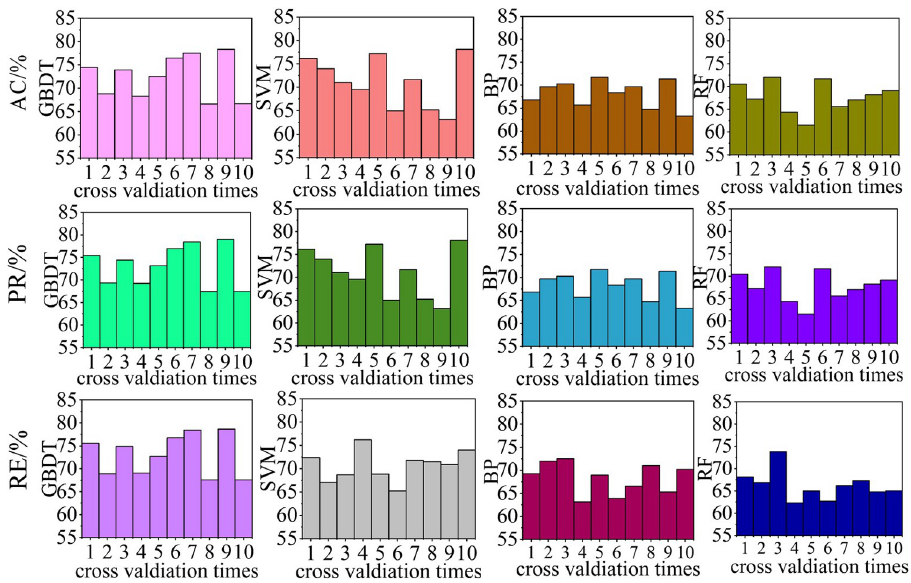
Fig 24. Disturbance information extraction performance comparison for algorithms with different classification models.